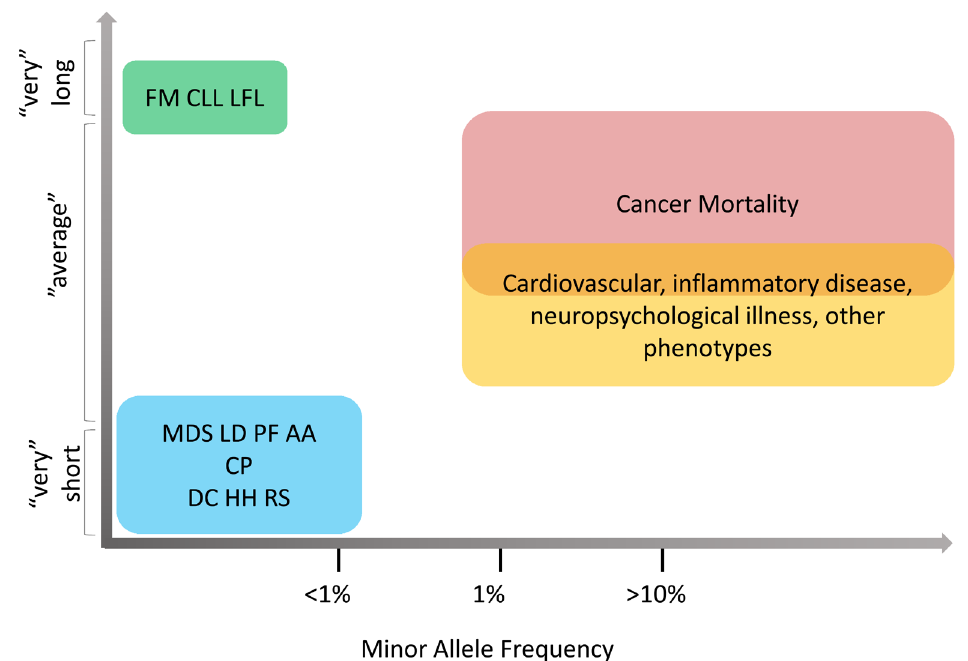
Figure 5. Relationship between telomere length, variant allele frequency, and human disease. The majority of genetic variants associated with common disease have a minor allele frequency (MAF) greater than 1% and telomeres in the “normal” range (that is, between the 1st and 99th percentiles for age). In contrast, genetic variants associated with rare and more highly penetrant disease are rare with MAF often much less than 1% and the extremes of telomere length. AA, aplastic anemia; CLL, chronic lymphocytic leukemia; CP, Coats plus; DC, dyskeratosis congenita; FM, familial melanoma; HH, Hoyeraal Hreidarsson syndrome; LD, liver disease; LFL, Li-Fraumeni-like syndrome; MDS, myelodysplastic syndrome; PF, pulmonary fibrosis; RS, Revesz